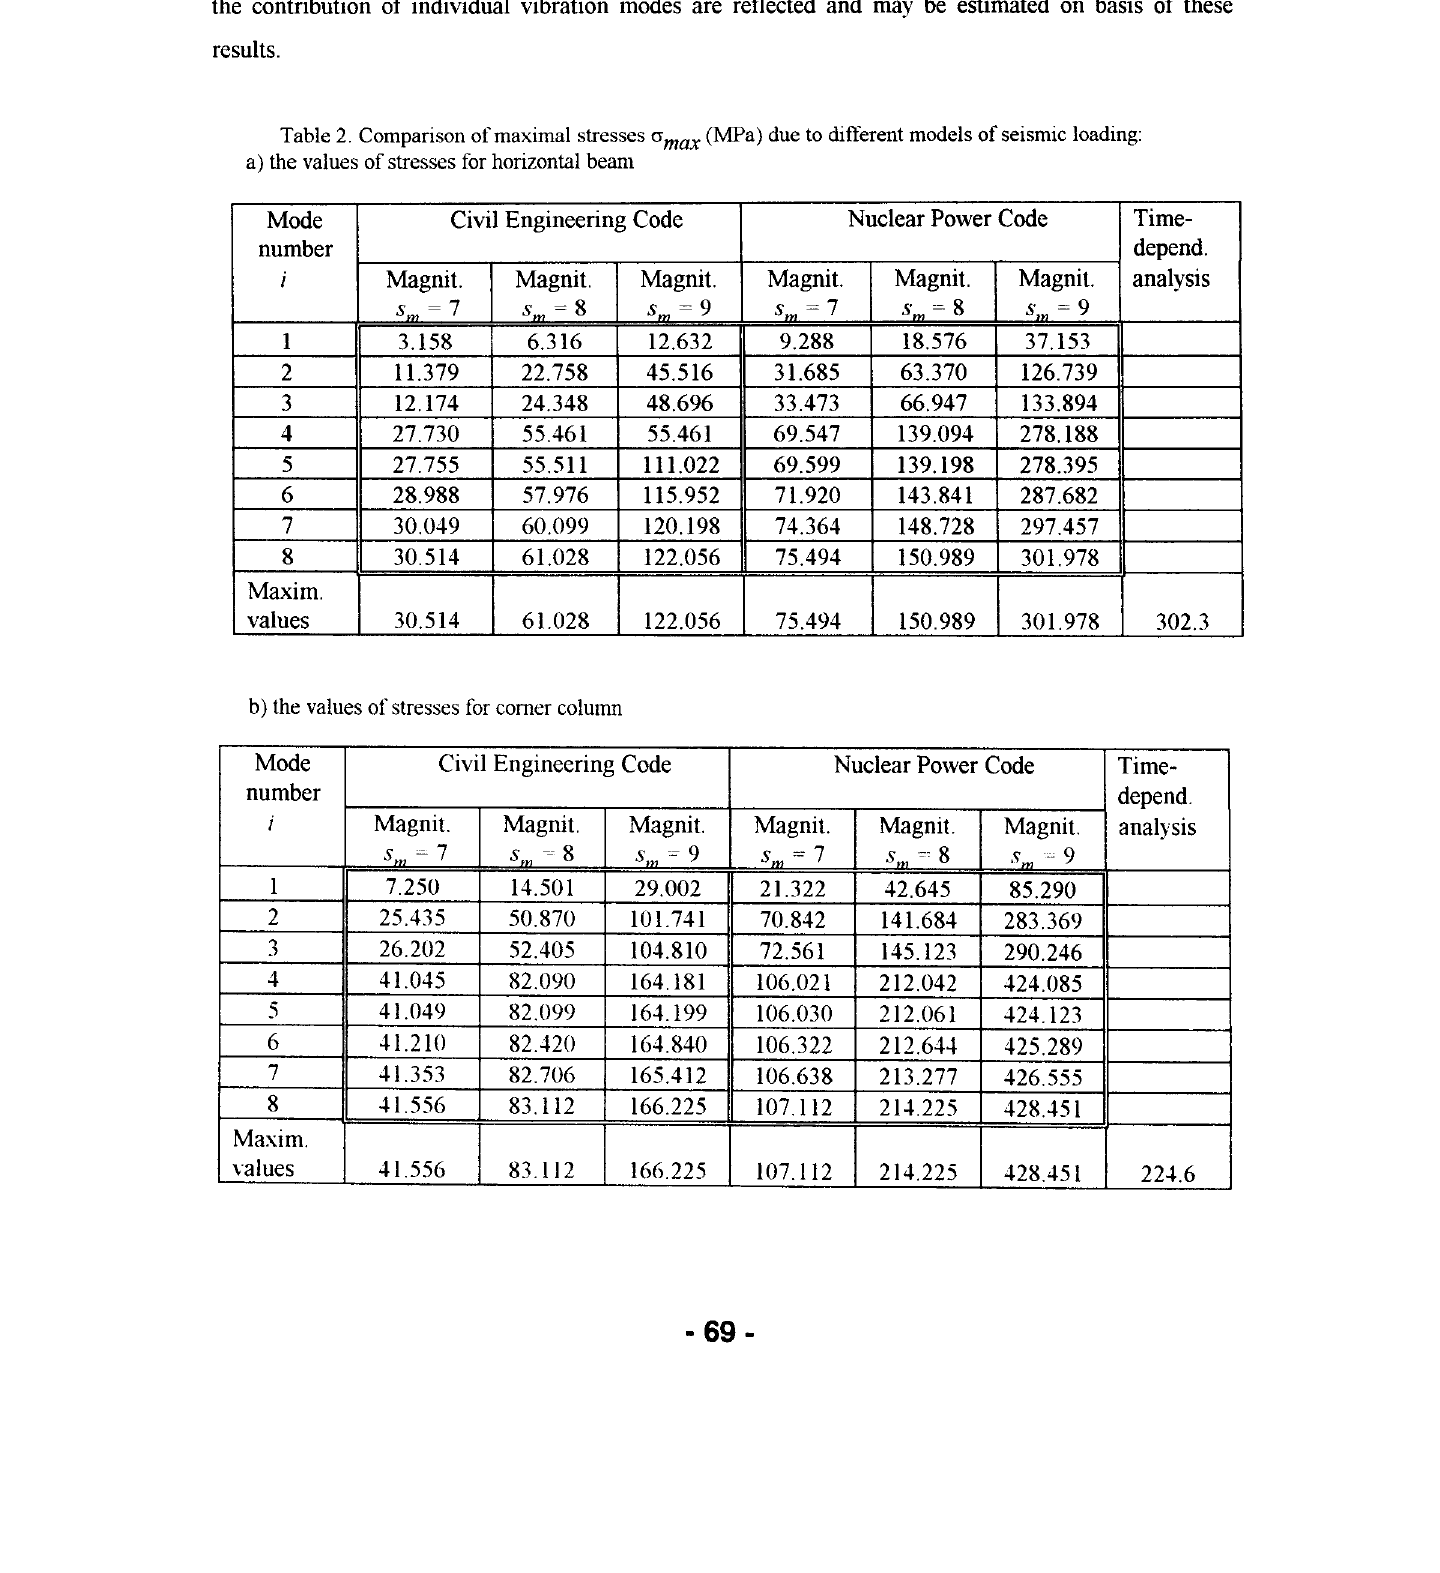
Table 2. Comparison of maximal stresses crmax (MPa) due to difierent models of seismic